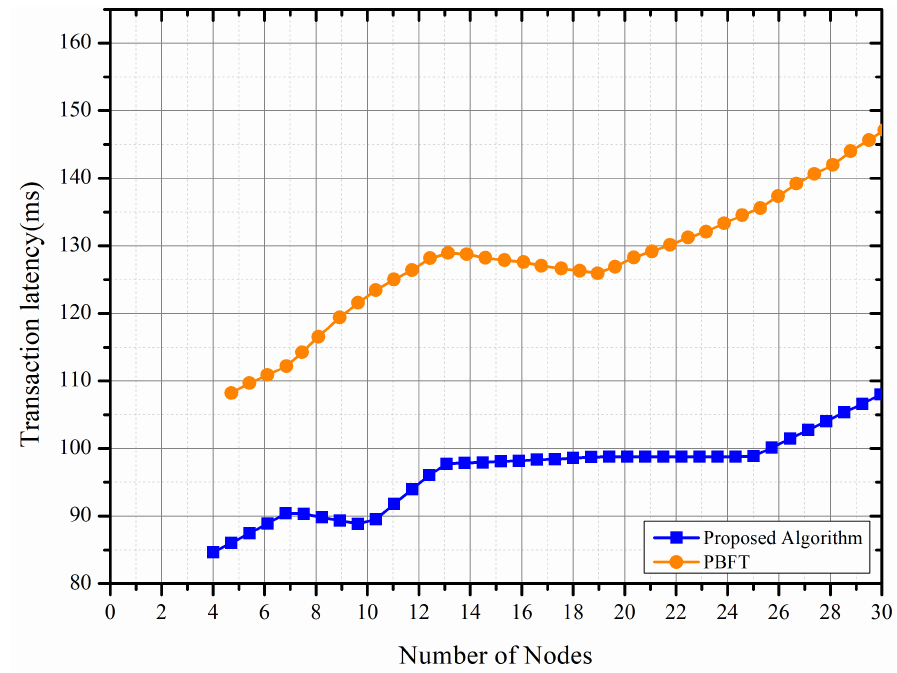
Figure 8. Transaction